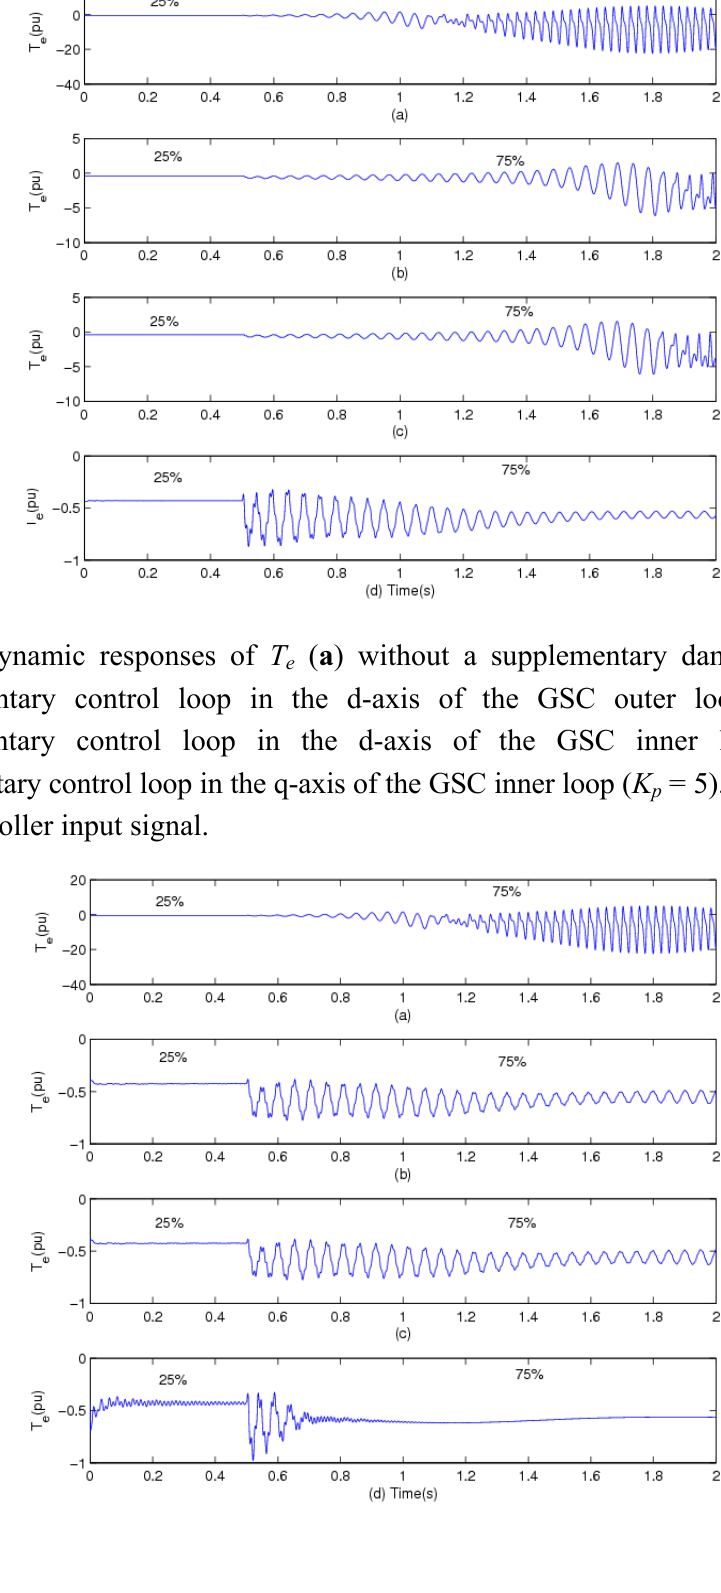
Figure 9. Dynamic responses of T ( b ) supplementary control loop in the d-axis of the GSC outer loop ( K ( c ) supplementary control loop in the d-axis of the GSC inner loop ( K ( d ) supplementary control loop in the q-axis of the GSC inner loop ( K damping controller input signal.